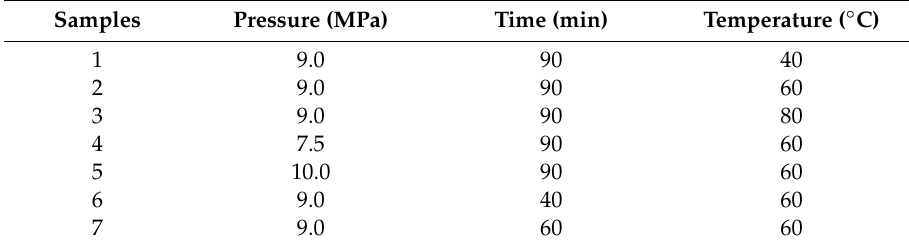
Table 1. Conditions of supercritical carbon dioxide (scCO 2 ) treatment for aramid fiber modification. Samples Pressure (MPa) Time (min) Temperature ( ◦